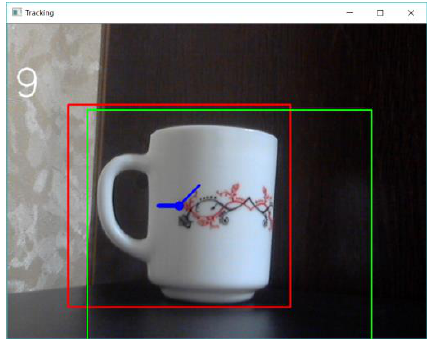
Figure 4. Object is not overlapped